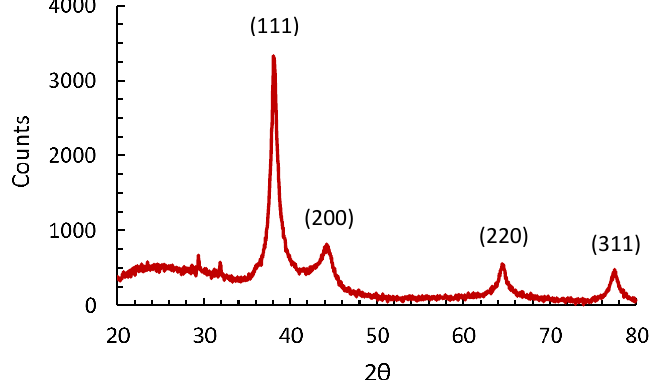
Figure 8. XRD pattern of the synthesized AgNPs.